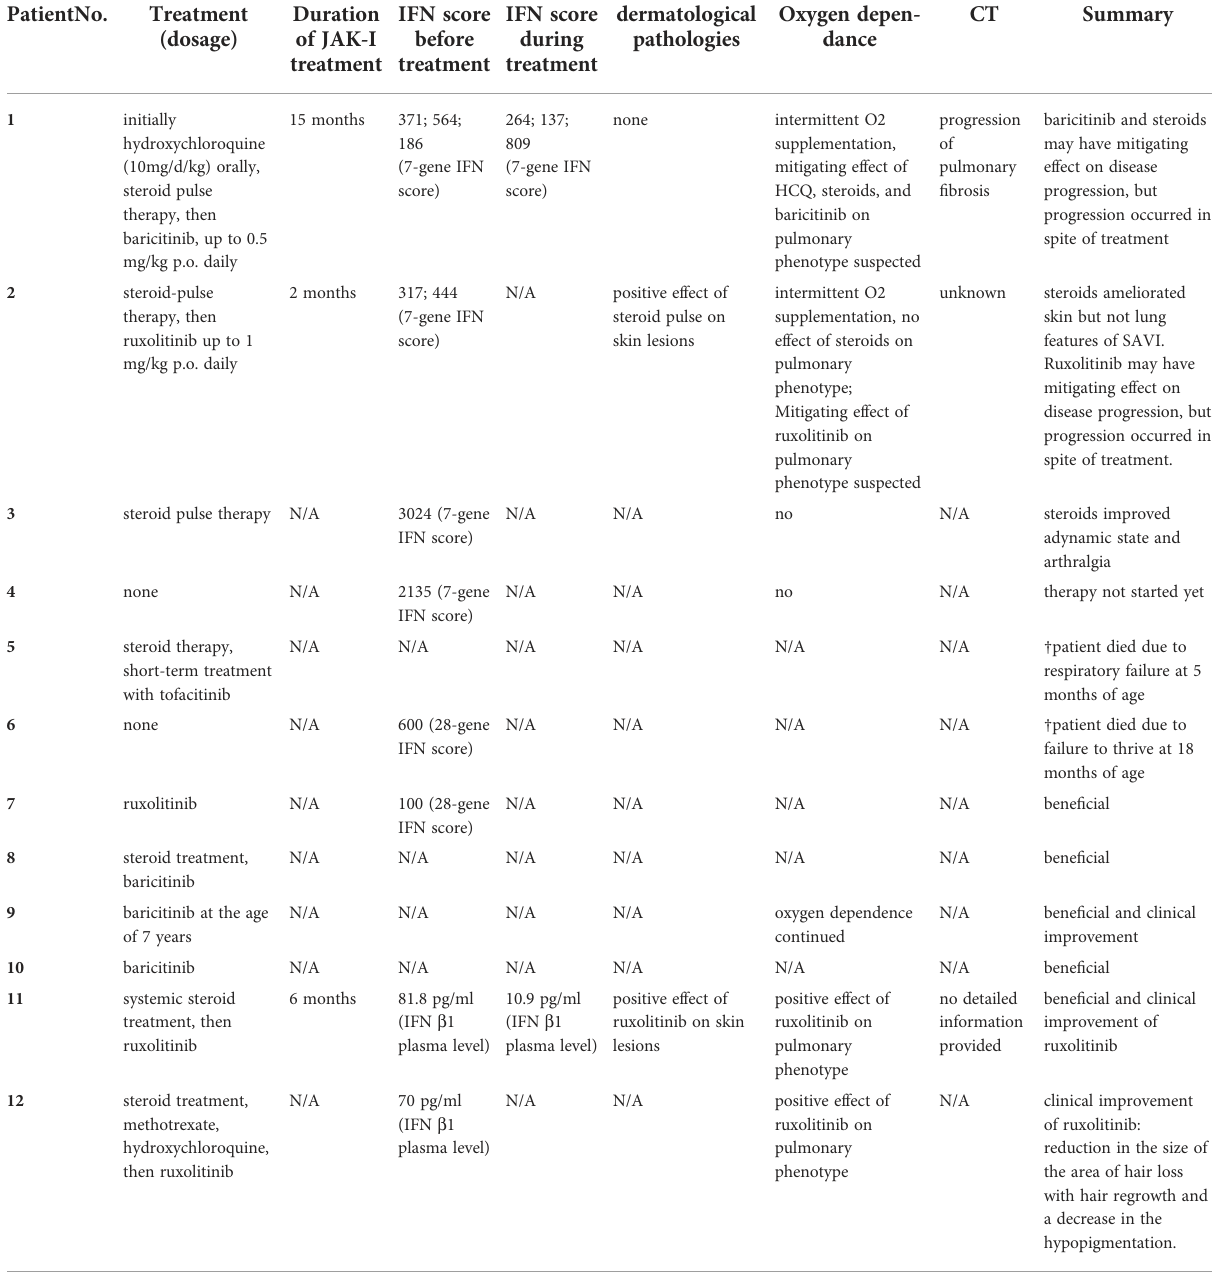
TABLE 2 Treatment regimens and therapy responses in AR SAVI in newly identi fi ed cases (patient 1-4) and cases from the literature [cases 5-12; (13, 14)]. PatientNo.